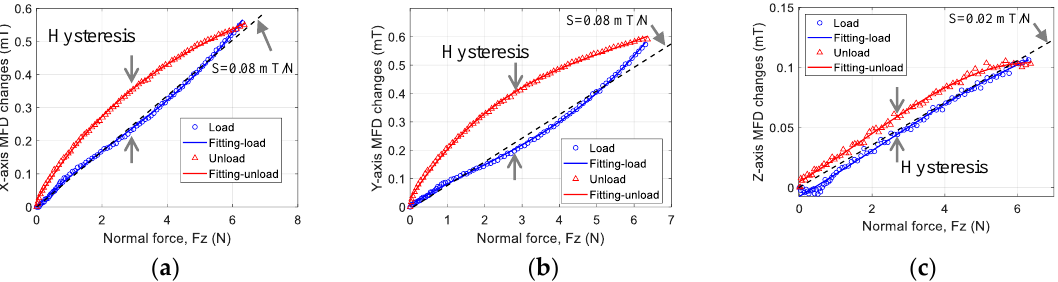
Figure 16. Sensor response curves in hysteresis tests for normal force along the ( a ) x-axis, ( b ) y-axis, and ( c ) z-axis.